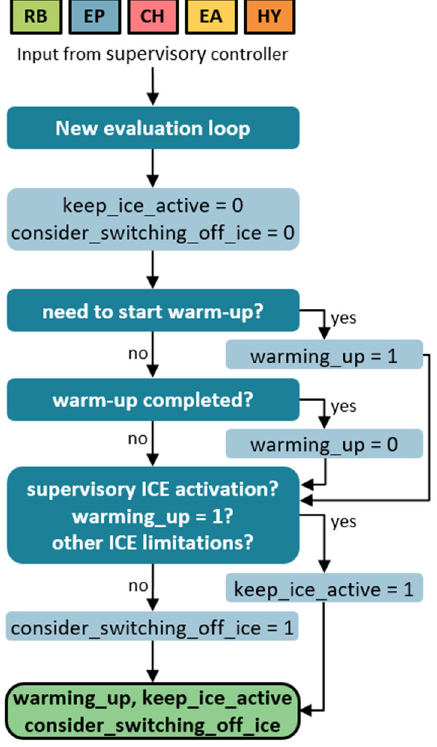
Figure 7. ICE Manager logic [22].